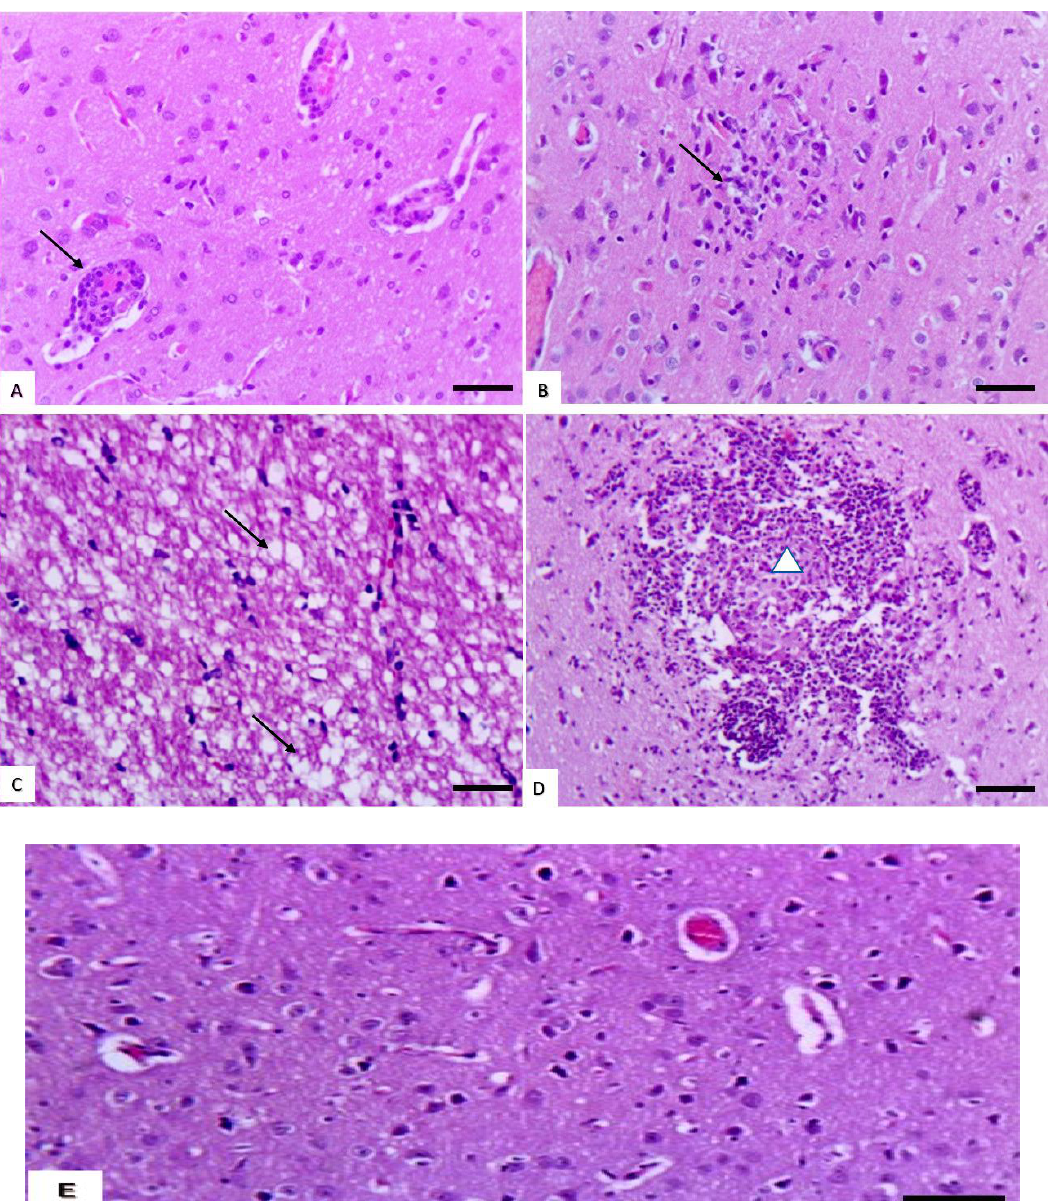
Figure 3. Effect of cymoxanil on the brain. ( A ) Brain of rats treated with medium dose showing perivascular cuff (arrows) (H&E, bar = 50 µm). ( B ) Brain of rats treated with medium dose showing slight gliosis (arrow) (H&E, bar = 50 µ m). ( C ) Brain of rats treated with high dose showing cerebral spongiosis (arrow) (H&E, bar = 50 µ m). ( D ) Brain of rats treated with high dose showing cerebral malacia (arrow) (H&E, bar = 50 µ m). ( E ) Brain of control showing intact neuronal cells and blood vessels surrounded with clear perivascular space in the neuropil of cerebrum (H&E, bar = 50 µ